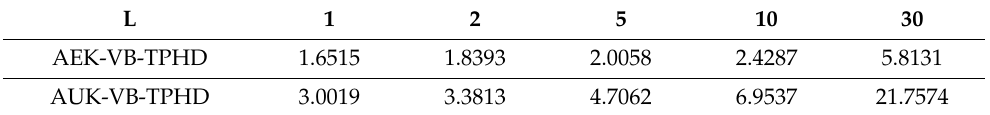
Table 3. The average run time of the AEK-VB-TPHD and AUK-VB-TPHD filters.